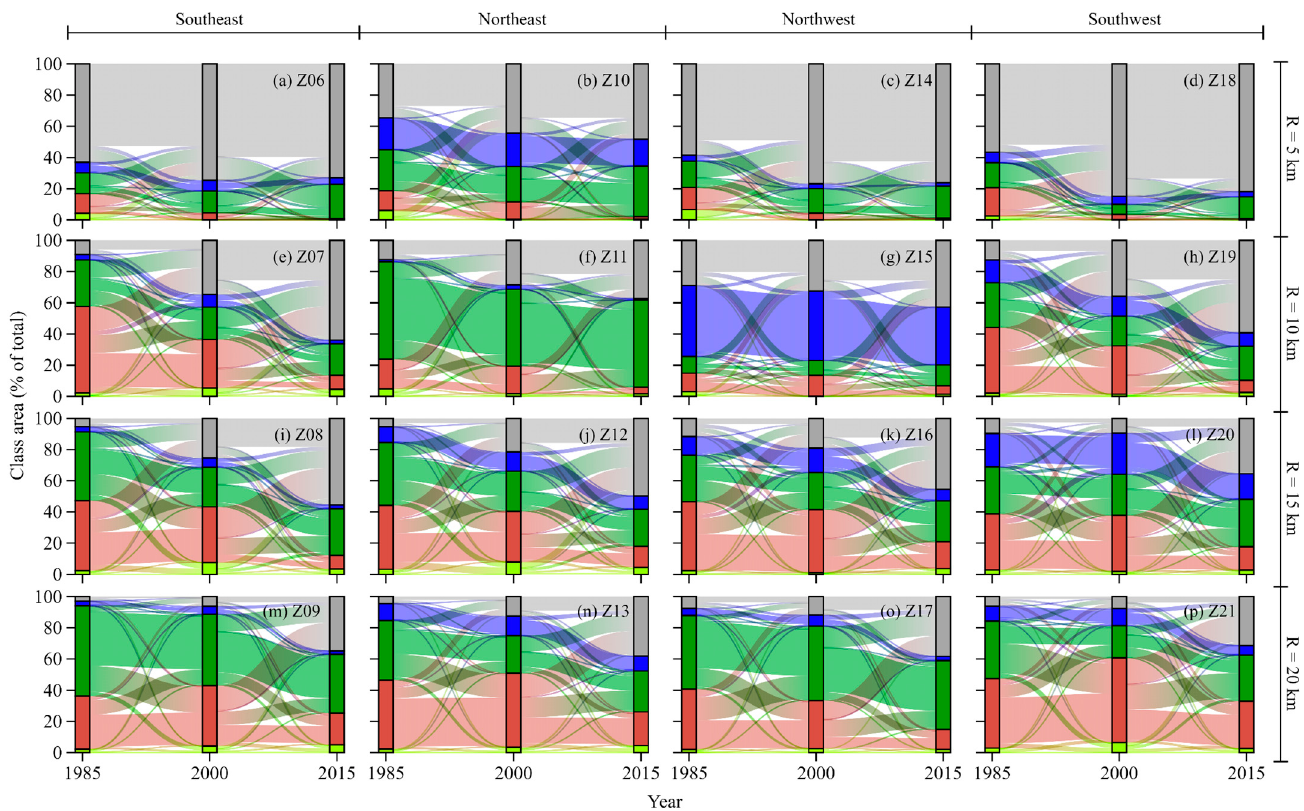
Figure A2. The modified Sankey charts to visualize the state and change flows of LULC for concentric pie zones (Z06–Z21) in Nanjing from 1985 to 2015.